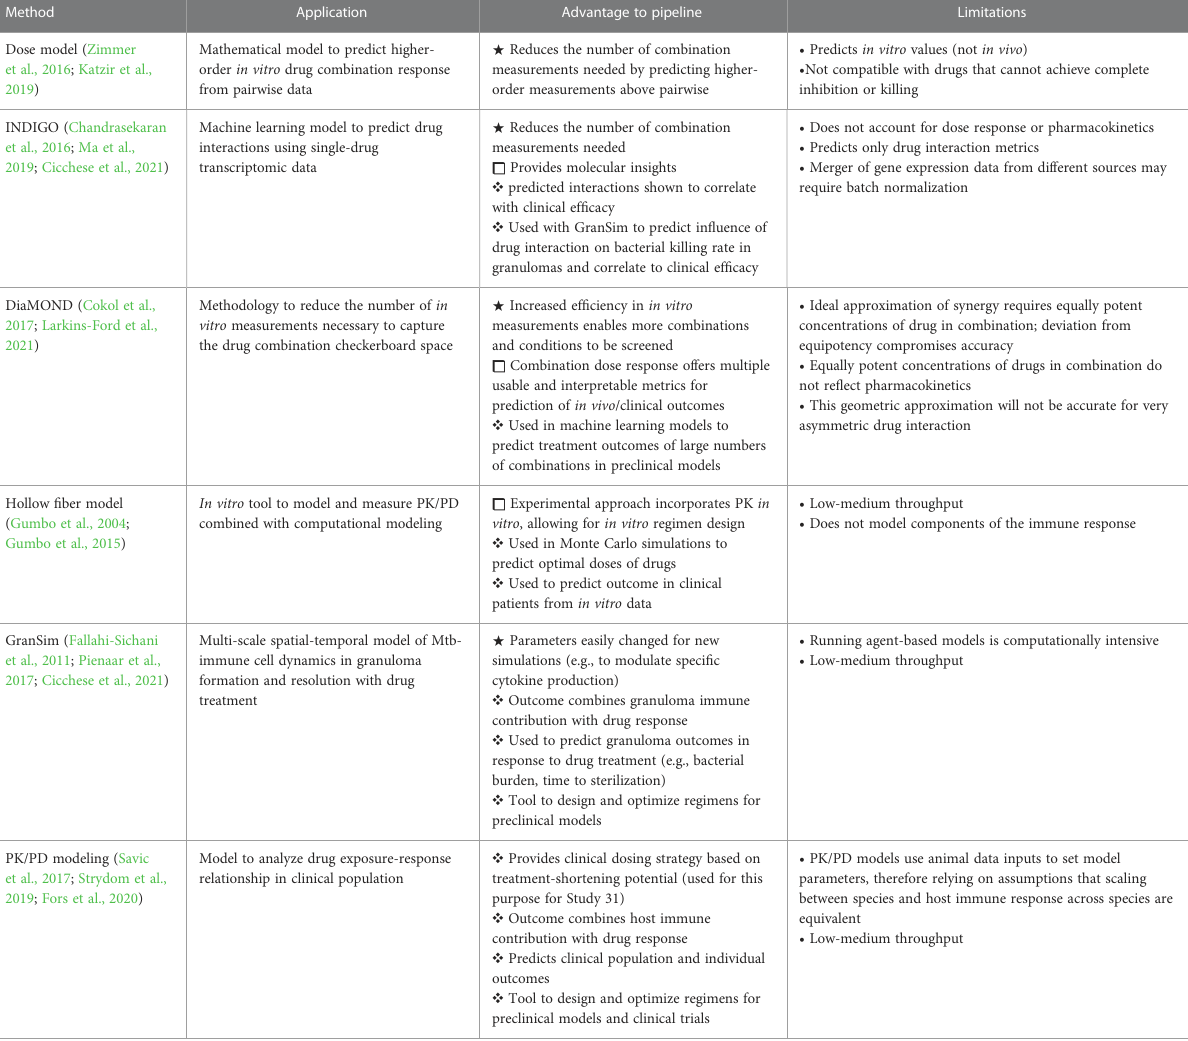
TABLE 1 Summary of mathematical frameworks and computational tools used to study drug combinations and PK/PD in TB.